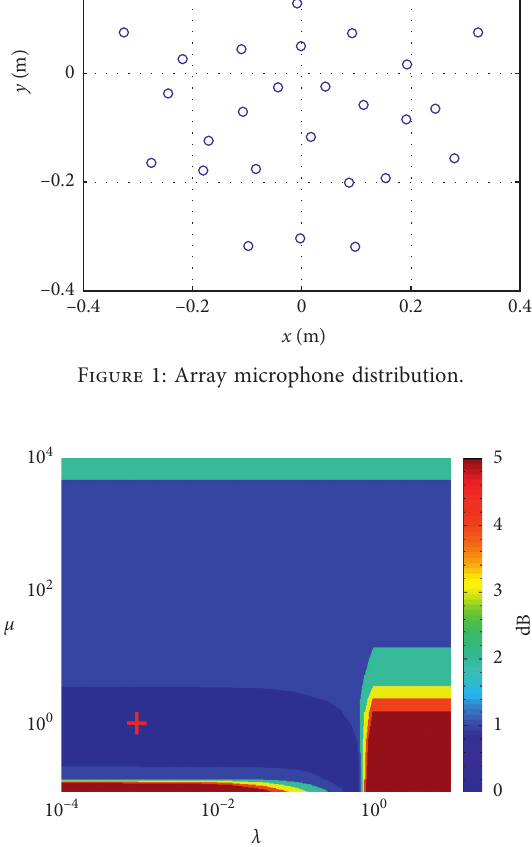
Figure 2: The map of average SPL deviation between the recon- structed and theoretical value vs. λ and μ